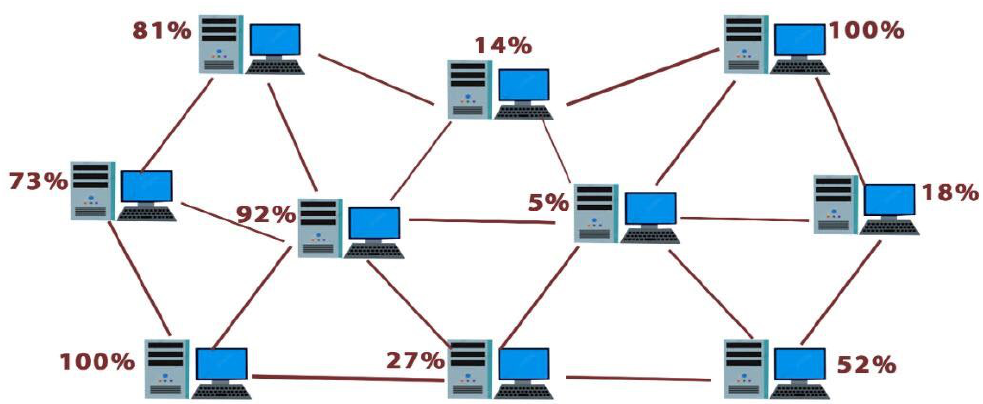
Figure 5. Decentralized node connections in peer-to-peer